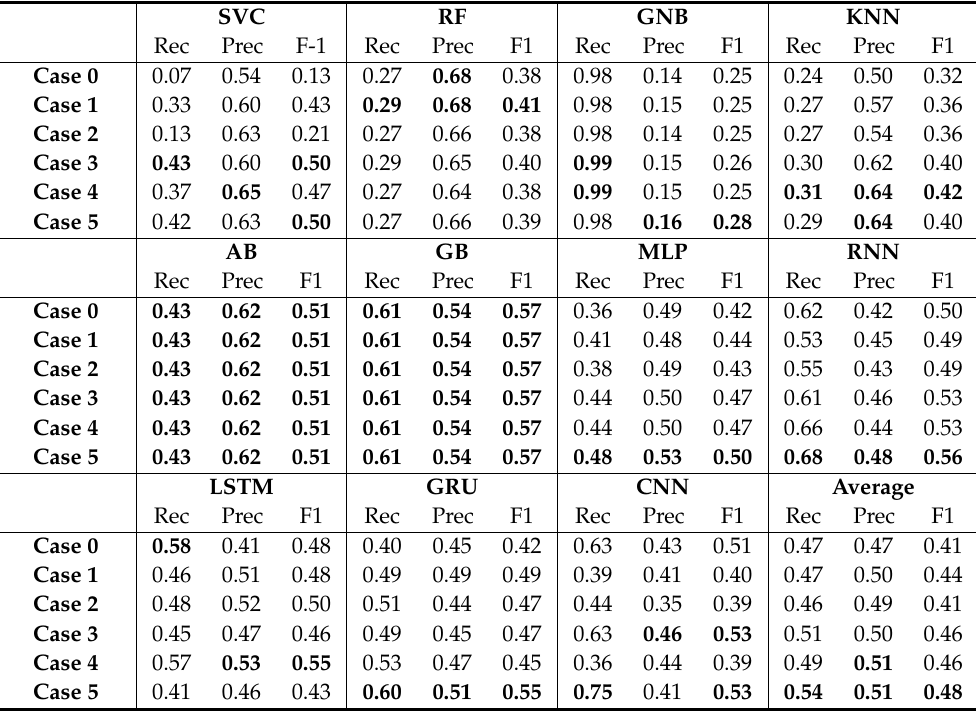
Table A5. Test results for induced/evolved rules used as an additional predictive feature, considering a time prediction horizon of +5 h.